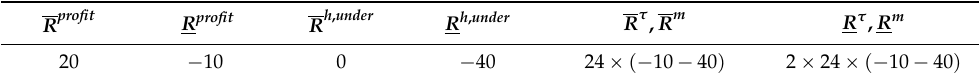
Table 2. The reward function